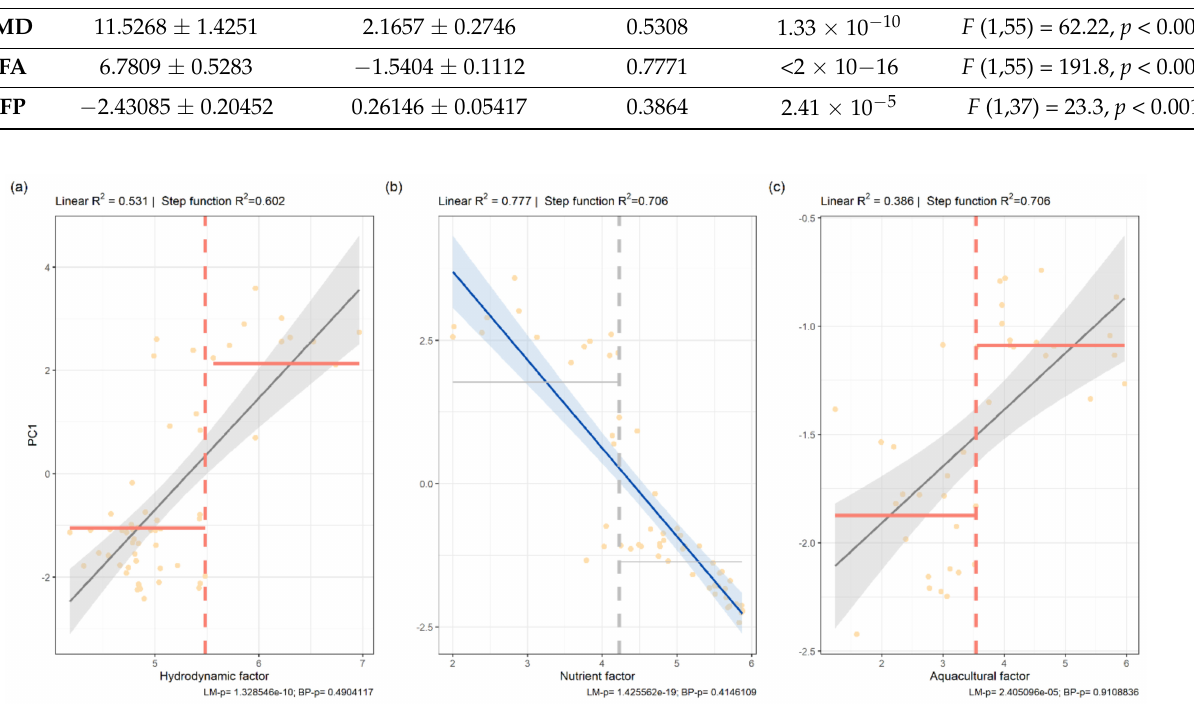
Figure 6. Regression models of the state-driver responses in Taibai Lake. ( a ) Hydrodynamic Factor; ( b ) Nutrient Factor; ( c ) Aquacultural